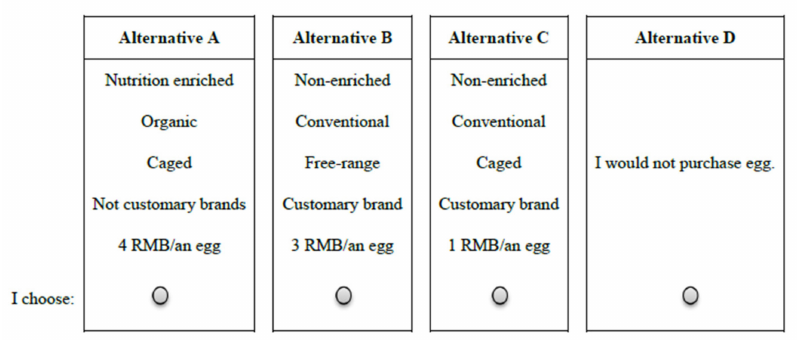
Figure 1. Example of a choice set used in the choice experiment